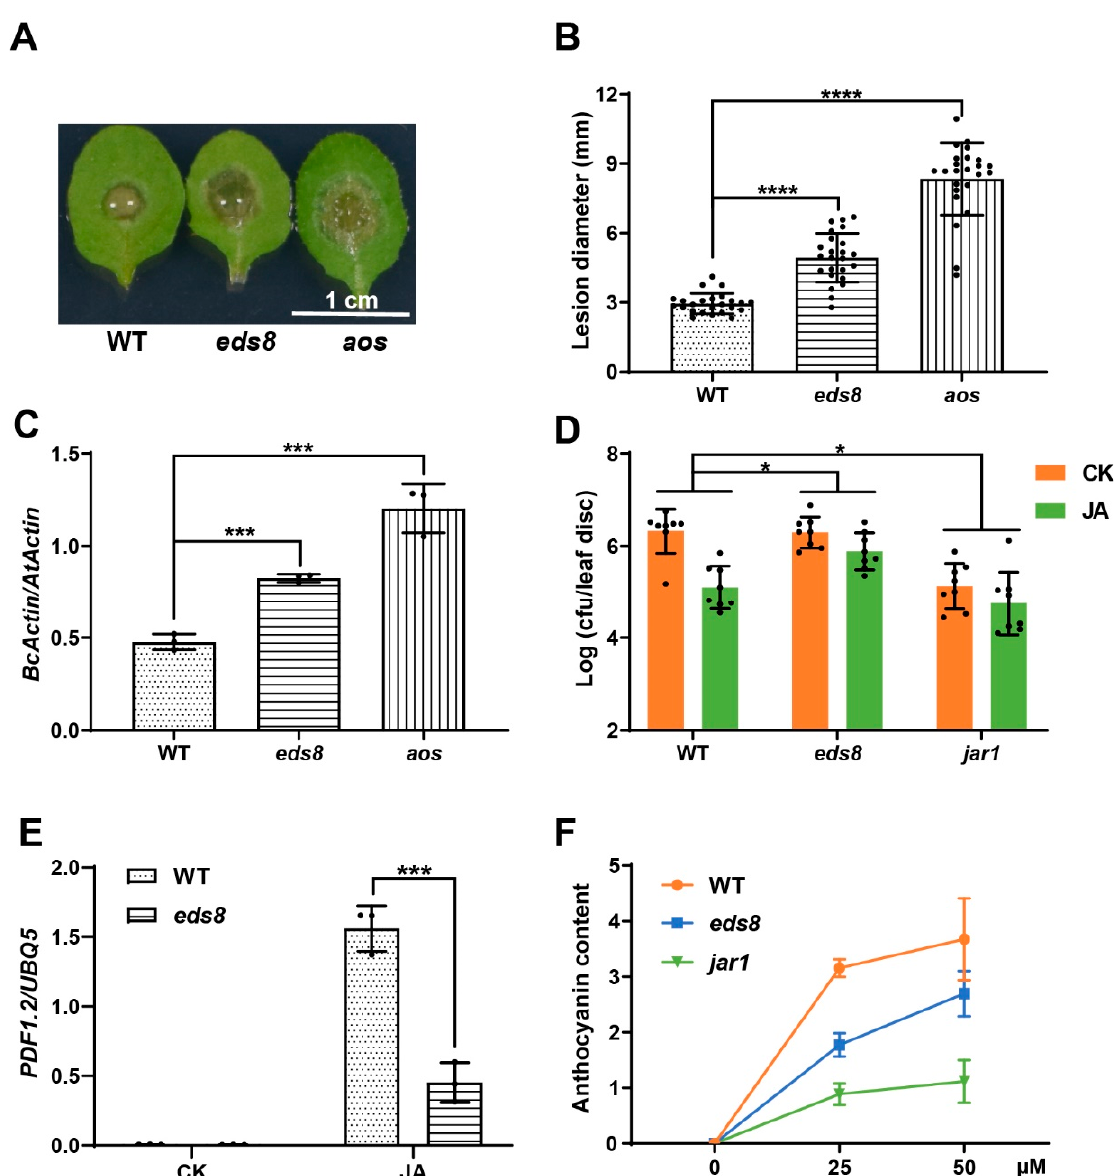
Figure 2. JA related phenotypes of the eds8 mutant. ( A – C ) The eds8 mutant was more susceptible to Botrytis cinerea . Third and fourth true leaves of three-week-old plants were inoculated with the spores of Botrytis cinerea (10 5 spores/mL). Photos were taken ( A ), lesion sizes were measured with ImageJ ( B ) and DNA was extracted for qPCR ( C ) at 36 h after pathogen inoculation. Significant difference was detected using Student’s t -test. Data are shown as mean ± SD ( n = 24). ( D ) JA induced resistance to Psm ES4326 in WT, eds8, and jar1 mutants. Three-week-old plants were sprayed with JA or H 2 O (CK) one day before pathogen infiltration (OD 600 = 0.001), and pathogen growth was determined three days later. Significant difference was detected by two-way ANOVA. Data are shown as mean ± SD ( n = 8). ( E ) JA induced expression of PDF1.2 in WT and eds8 mutants. Twelve-day-old seedlings were sprayed with JA or H 2 O (CK), and samples were collected one day after treatment. Significant difference was detected using Student’s t -test. Data are shown as mean ± SD ( n = 3). ( F ) JA induced anthocyanin accumulation assay. Seeds were sowed onto 1/2 MS plates with a different concentration of JA, and the anthocyanin accumulation was determined 14 days later. Data are shown as mean ± SD ( n = 3). All these experiments were repeated three times with similar results. * p < 0.05; *** p < 0.001; **** p < 0.0001.